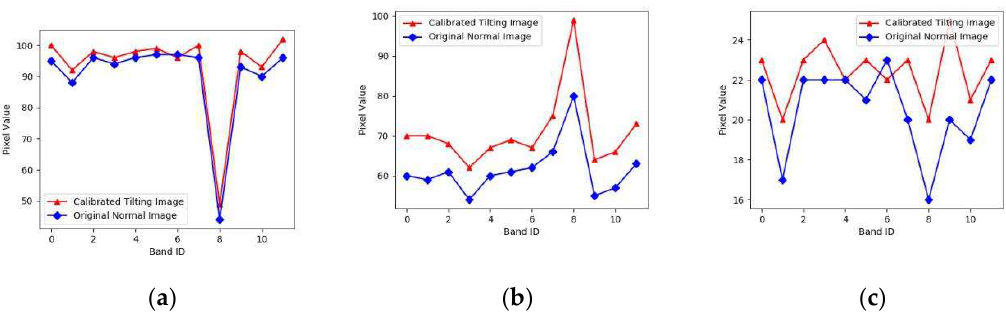
Figure 10. DN Mean-value curve of the same object area both of normal image and restored tilting the image. ( a ) Mean-value curve of corresponding area 1; ( b ) mean-value curve of corresponding area 2; ( c ) mean-value curve of corresponding area 3.